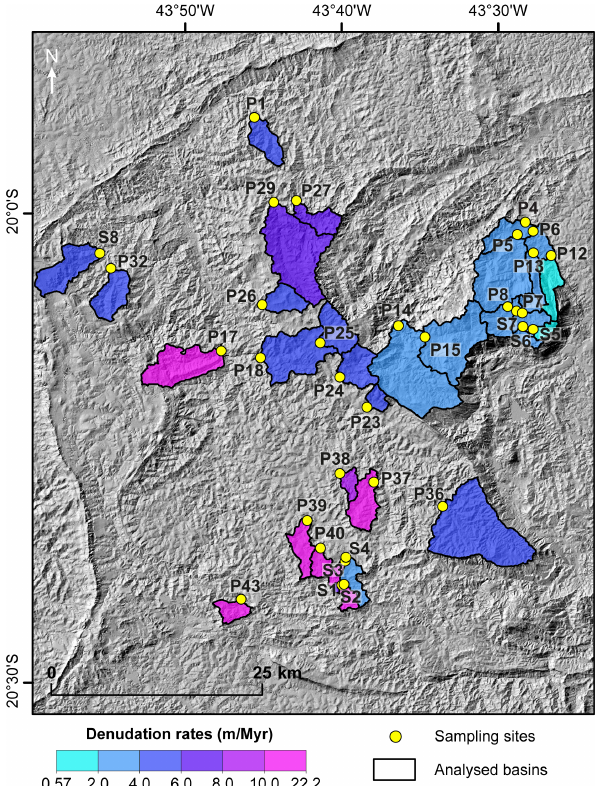
Figure 3. Catchment-averaged denudation rates in the study area draped over a hillshade image. Note that we identify the 25 sam- pling sites of this study with “P” followed by a number, whereas we label the 8 sampling sites incorporated from Salgado et al. (2008) with “S” followed by a number. See Table S1 for 10 Be analytical results and derived denudation rate